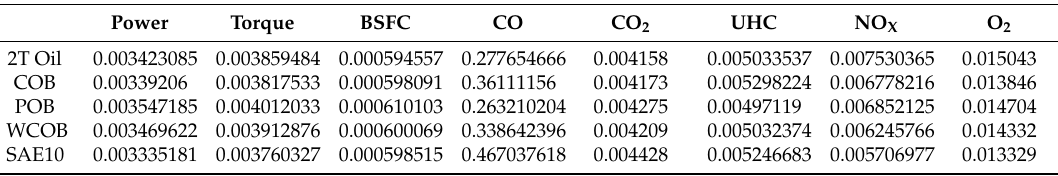
Table 7. The weighted dimensionless decision